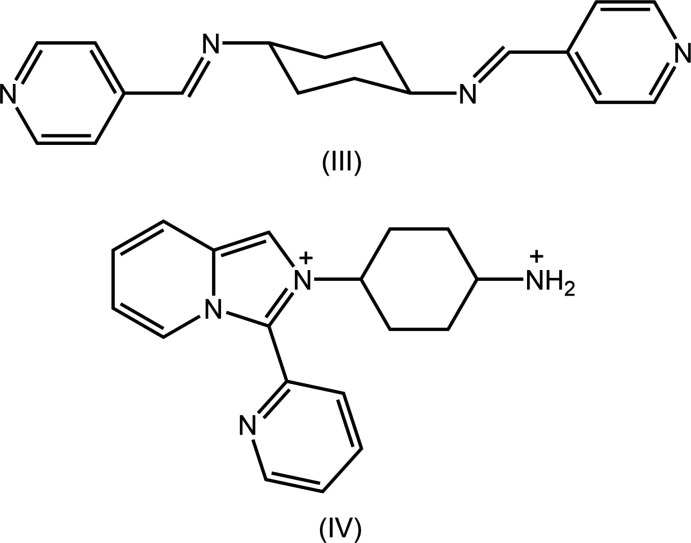
Chemical diagrams for (III) and (IV).